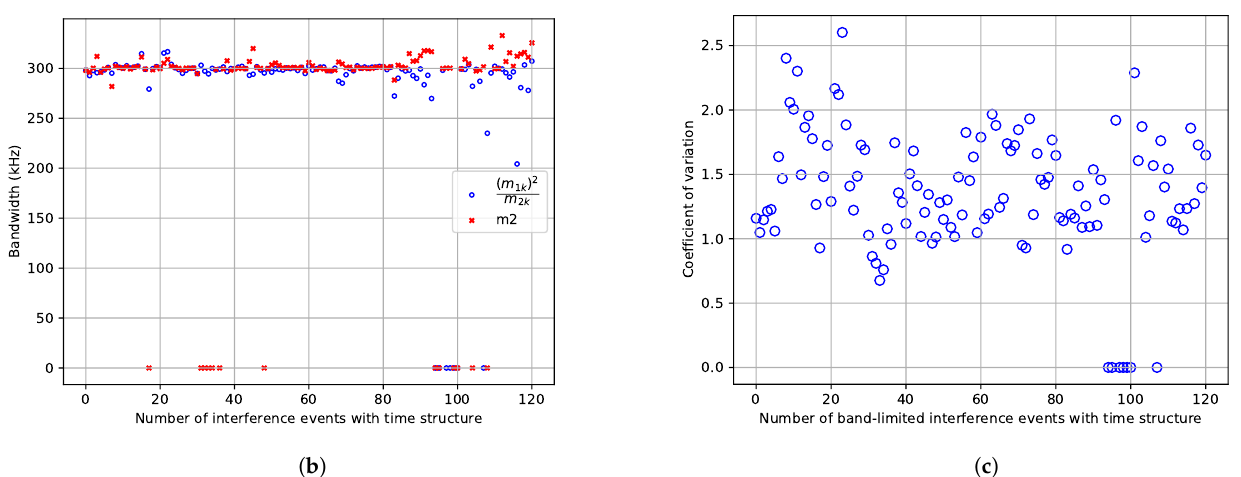
Figure 13. Detection of band-limited interference, estimation of bandwidth, and CV. ( a ) Measurement location where band-limited interference (red crosses) and wide-band interference (black circles) with time structure was detected by visual analysis, rest of locations (blue stars), ground radar locations (black triangles with numbers) [21,31]. 1: Massachusetts (U.S.), 2: Texas (U.S.), 3: California (U.S.), 4: Georgia (U.S.), 5: Florida (U.S.), 6: North Dakota (U.S.), 7: Alaska (U.S.), 8: Thule (Greenland), 9: Fylingdales Moore (United Kingdom), 10: Pirinclik (Turkey). ( b ) Automatic bandwidth estimation using two parameters: the ratio of moments, ( m 1 k ) 2 / m 2 k ; and the average power spectrum ( m 2 k ). The cases with zero bandwidth corresponds to when the automatic detection failed. ( c ) The median of the CV over the bandwidth of the automatically detected band-limited interference. The cases with zero correspond to when the automatic detection failed. A high coefficient indicates high spread in the measured